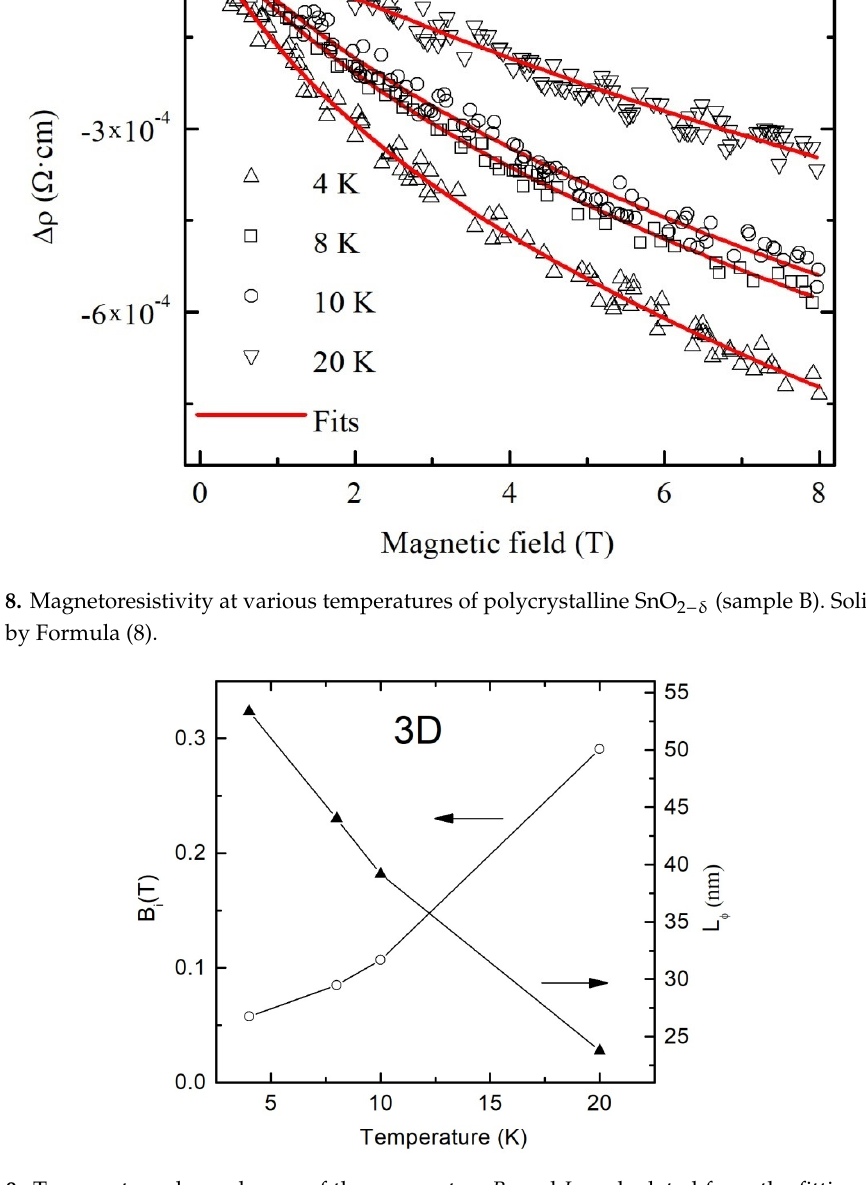
Figure 9. Temperature dependences of the parameters B i and L ϕ calculated from the fitting curves using Formulas (8) and (10) for polycrystalline SnO 2 − δ film (sample B).